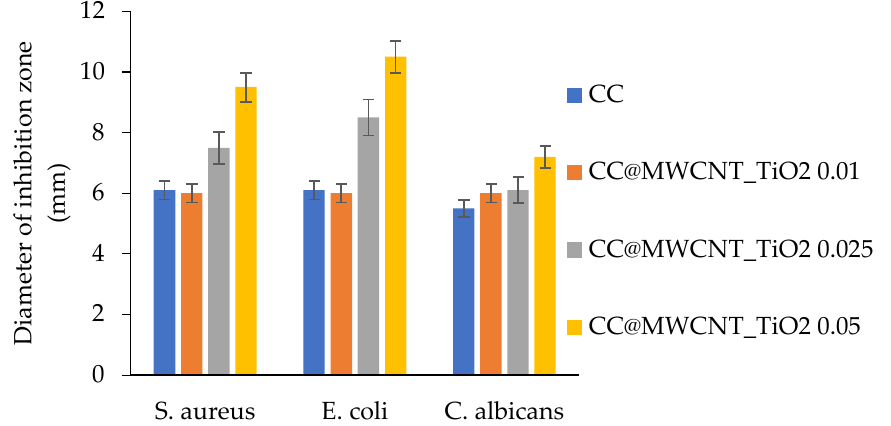
Figure 3. The antimicrobial activity of the films against the S. aureus , E. coli bacteria and the C. Albicans fungi. CC—cellulose acetate-collagen, MWCNT—multi-walled carbon nanotubes, 0.01, 0.025, 0.05—the weight (g) of MWCNT_TiO 2 added to the solution of cellulose acetate and collagen in acetic acid and water.